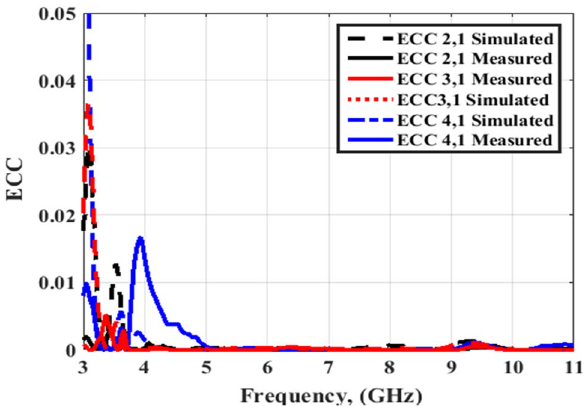
Figure 21. Port #1 ECC simulated and testing outcomes of the flexible MIMO antenna in bending configuration with R = 45